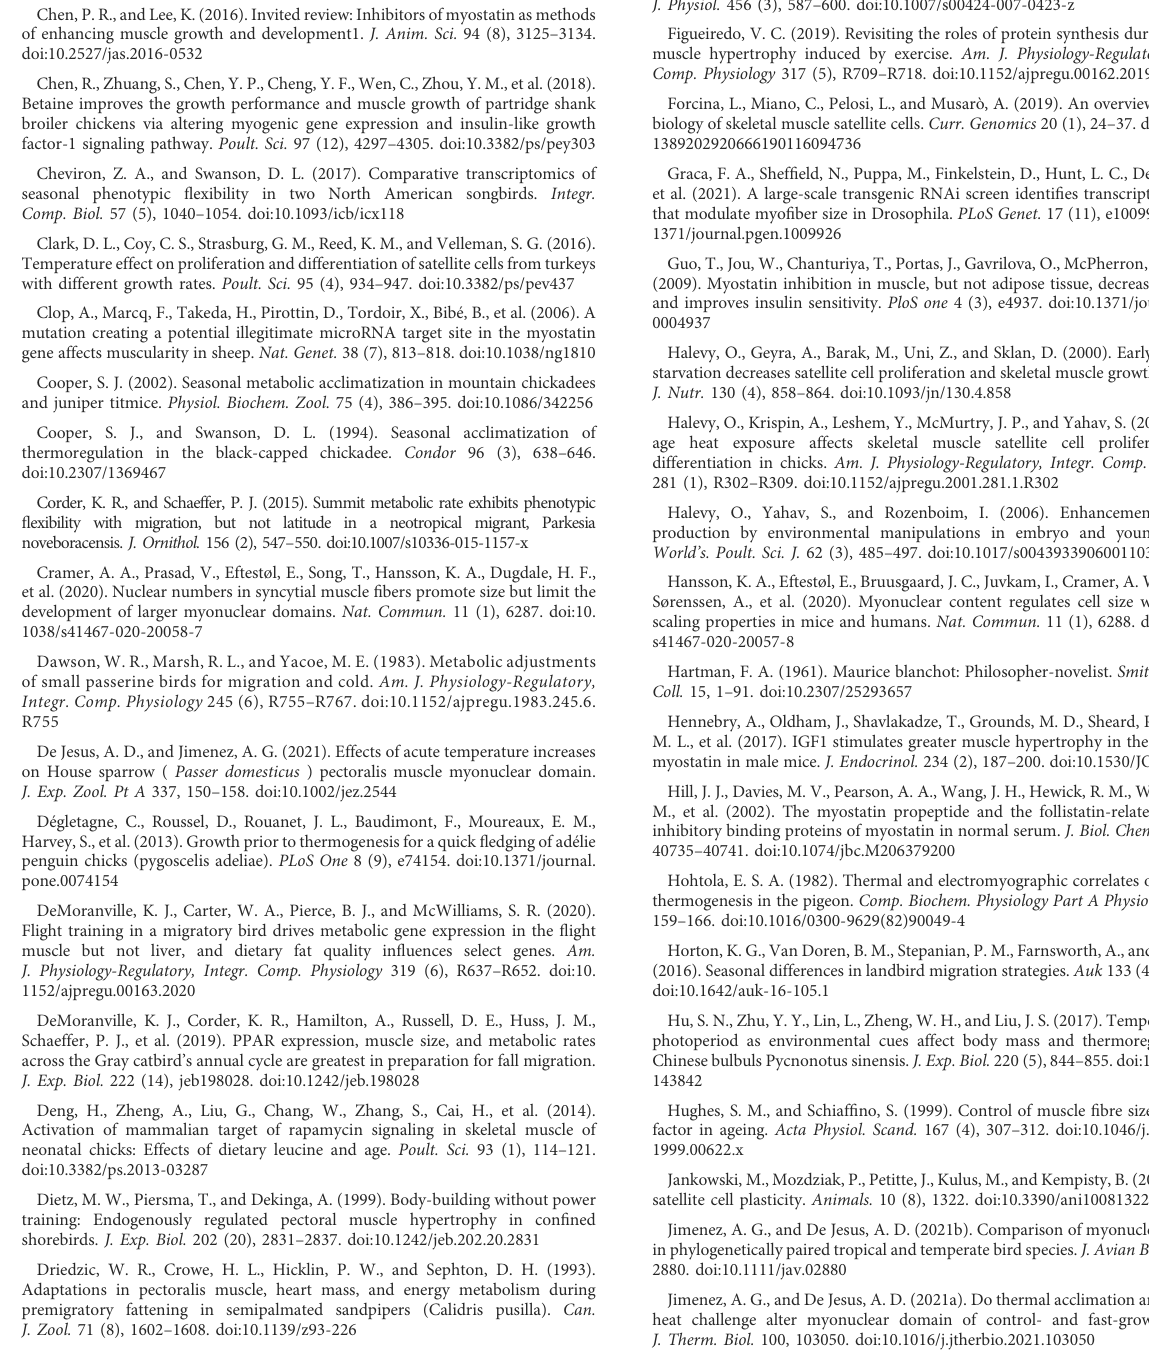
Figueiredo, V. C. (2019). Revisiting the roles of protein synthesis during skeletal muscle hypertrophy induced by exercise. Am. J. Physiology-Regulatory,